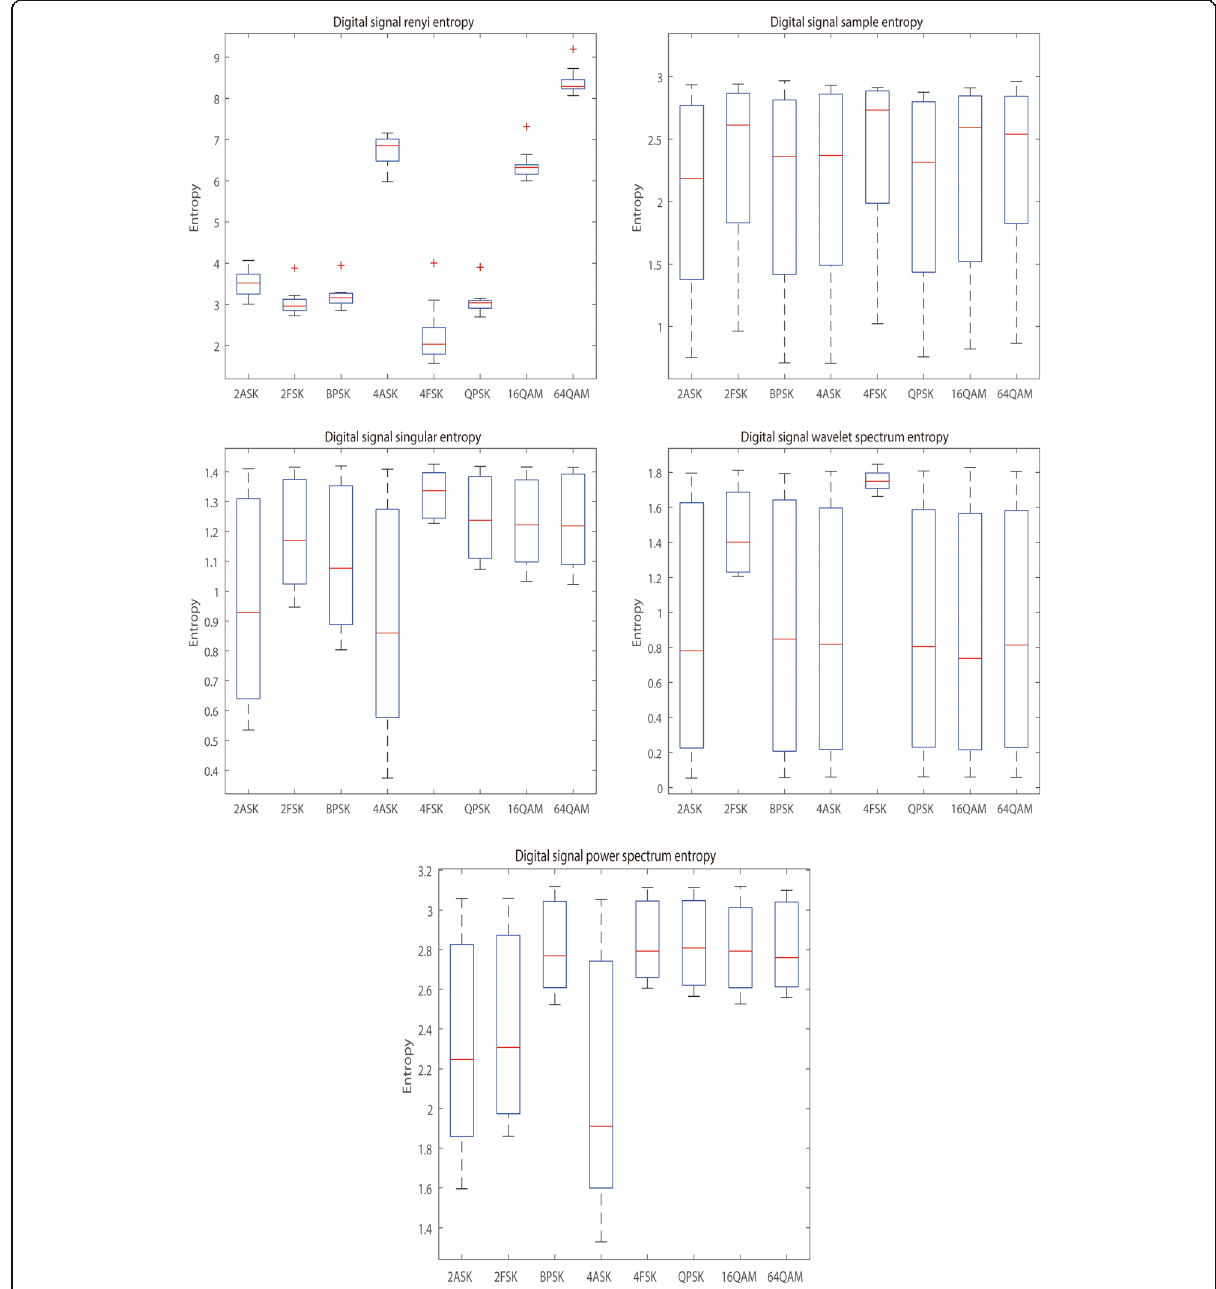
Fig. 2 The distribution of entropy feature in different signals in mixture SNR (from − 10 dB to 20 dB) with margin 3 dB. Five points are shown which include maximum, 75th percentile, median, 25th percentile, and